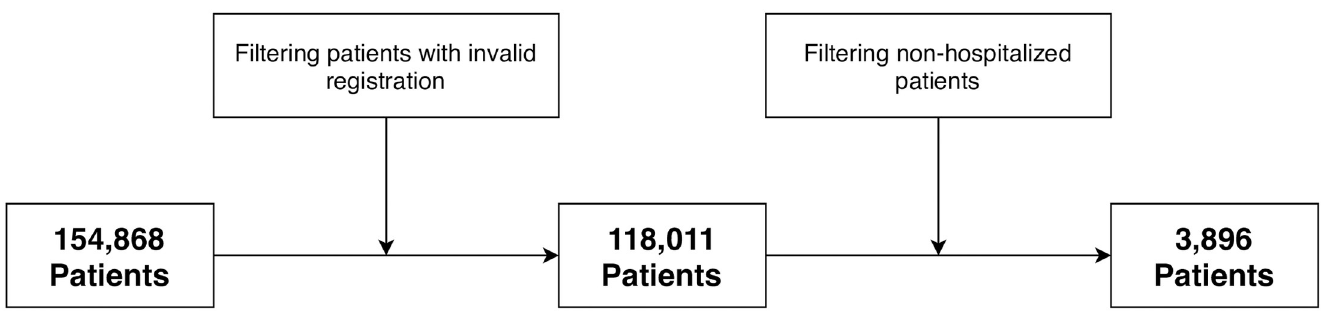
Fig 1. Data processing overview. The dataset provided by SESAB contained a total of 154,868 patients that were detected with COVID-19 in the state of Bahia, Brazil. After removing the patients with invalid data ( e.g ., notification year prior to 2020, length of hospital stay lower than zero, age lower than zero, unknown outcome), the dataset contained a total of 118,011 patients with valid registration. Finally, we removed the patients that were not admitted to a hospital, restricting our evaluation to a final count of 3,896 patients.